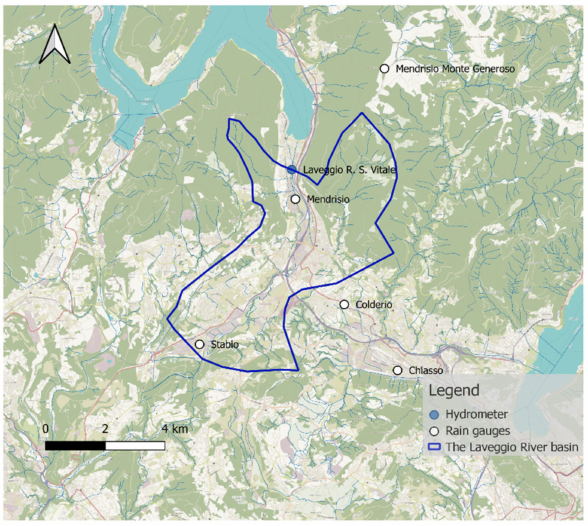
Figure 3. Location of the Laveggio River basin and the relative measurement stations. Map data ©